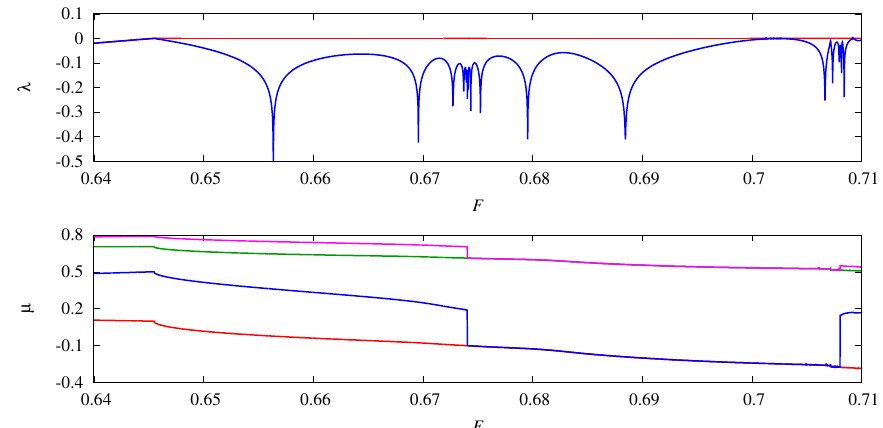
Figure 4. Top panel: the two largest Lyapunov exponents plotted as a function of the parameter F for the system L − 1,0, − 1 ( n ) for dimension n = 4. Bottom panel: the quantities µ 0 , · · · , µ 3 , as defined in Equation (8) plotted as a function of F .